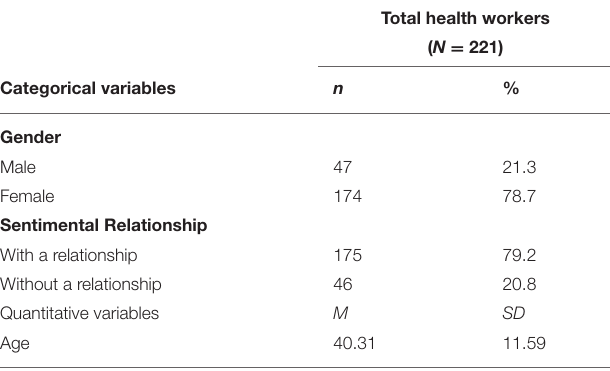
TABLE 1 | Sociodemographic data of the total sample.